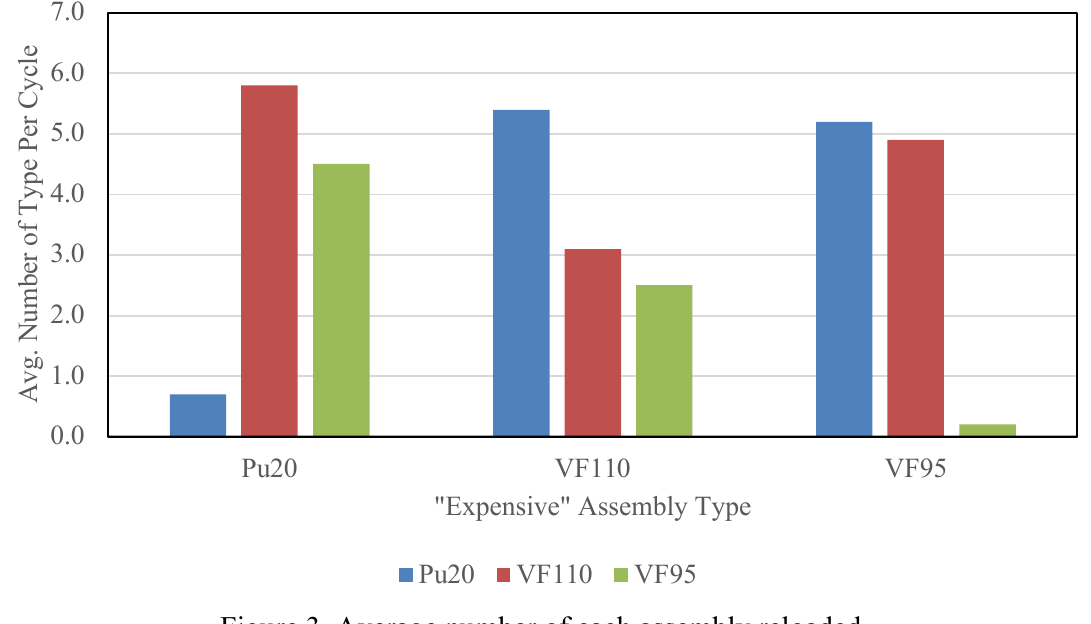
Figure 3. Average number of each assembly